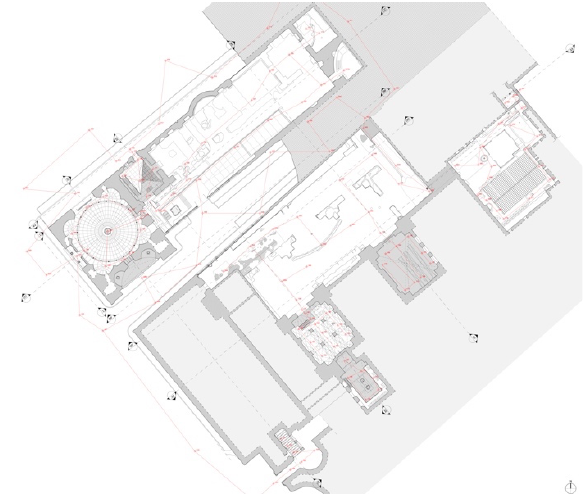
Figure 06 . Identification of the laser scanner survey points relative to the L00 level detected. Depending on the detected environment, the degree of definition of the scan changes.